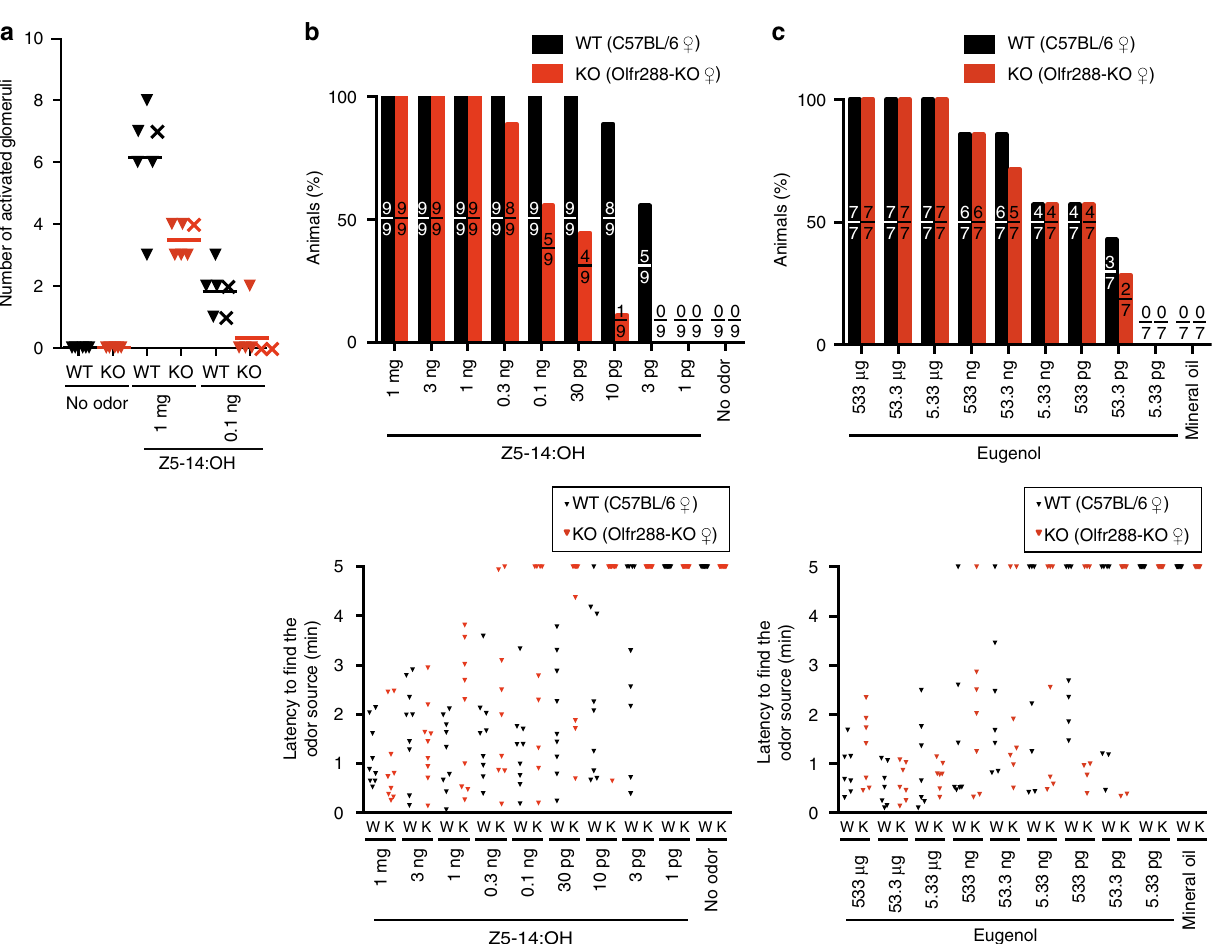
Fig. 2 Presence of ~3 ORs for Z5 – 14:OH, including Olfr288, and the effect of Olfr288 deletion on detection of Z5 – 14:OH. a Number of activated glomeruli in the olfactory bulb of C57BL/6 adult female mice (WT) and Olfr288-KO adult female mice (KO) stimulated with 1 mg and 0.1 ng Z5 – 14:OH ( N = 6) or without any stimulation ( N = 5). c-Fos, an immediate early gene product, was used as an indicator of glomerular activation. Mann – Whitney test: 1 mg Z5 – 14:OH; P = 0.0635, 0.1 ng Z5 – 14:OH; P = 0.1143. Each triangle symbol depicts the result of immunohistochemistry and each cross symbol depicts the result of in situ hybridization. b Odor- fi nding test for Z5 – 14:OH in C57BL/6 adult female mice (WT) and Olfr288-KO adult female mice (KO) ( N = 9). (Upper panel) The percentage of animals that found the odor sources within 5 min. The ratio of the number of animals that found the odor sources to the number of total animals that were tested is shown inside each bar. There were signi fi cant differences between WT and KO, as determined by the Scheirer – Ray – Hare test. ** P < 0.01. (Lower panel) Latency to fi nd the odor source in C57BL/6 mice (W) and Olfr288-KO mice (K). Each triangle depicts a single individual. Animals that failed to fi nd Z5 – 14:OH in 5 min were plotted at 5. c Odor- fi nding test for eugenol in C57BL/6 adult female mice (WT) and Olfr288-KO adult female mice (KO) ( N = 7). (Upper panel) The percentage of animals that found the odor sources within 5 min. There were no signi fi cant differences between WT and KO, as determined by the Scheirer – Ray – Hare test (0.950 < P < 0.975). (Lower panel) Latency to fi nd the odor source in C57BL/6 mice (W) and Olfr288-KO mice (K). Each triangle depicts a single individual. Animals that failed to fi nd eugenol in 5 min were plotted at